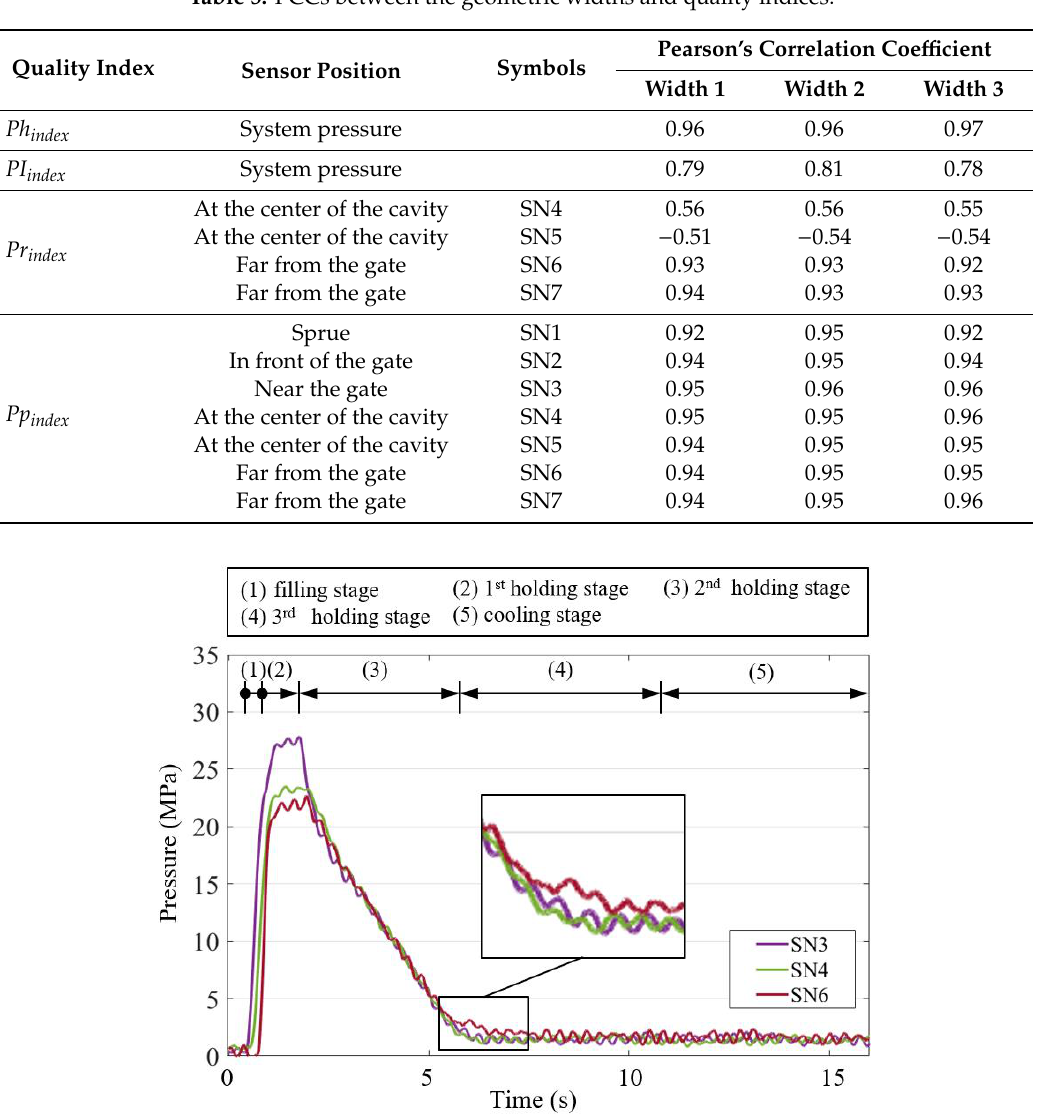
Figure 13. Back-flow phenomenon caused by relatively low cavity pressure distribution at the center of the cavity (SN4) during holding.